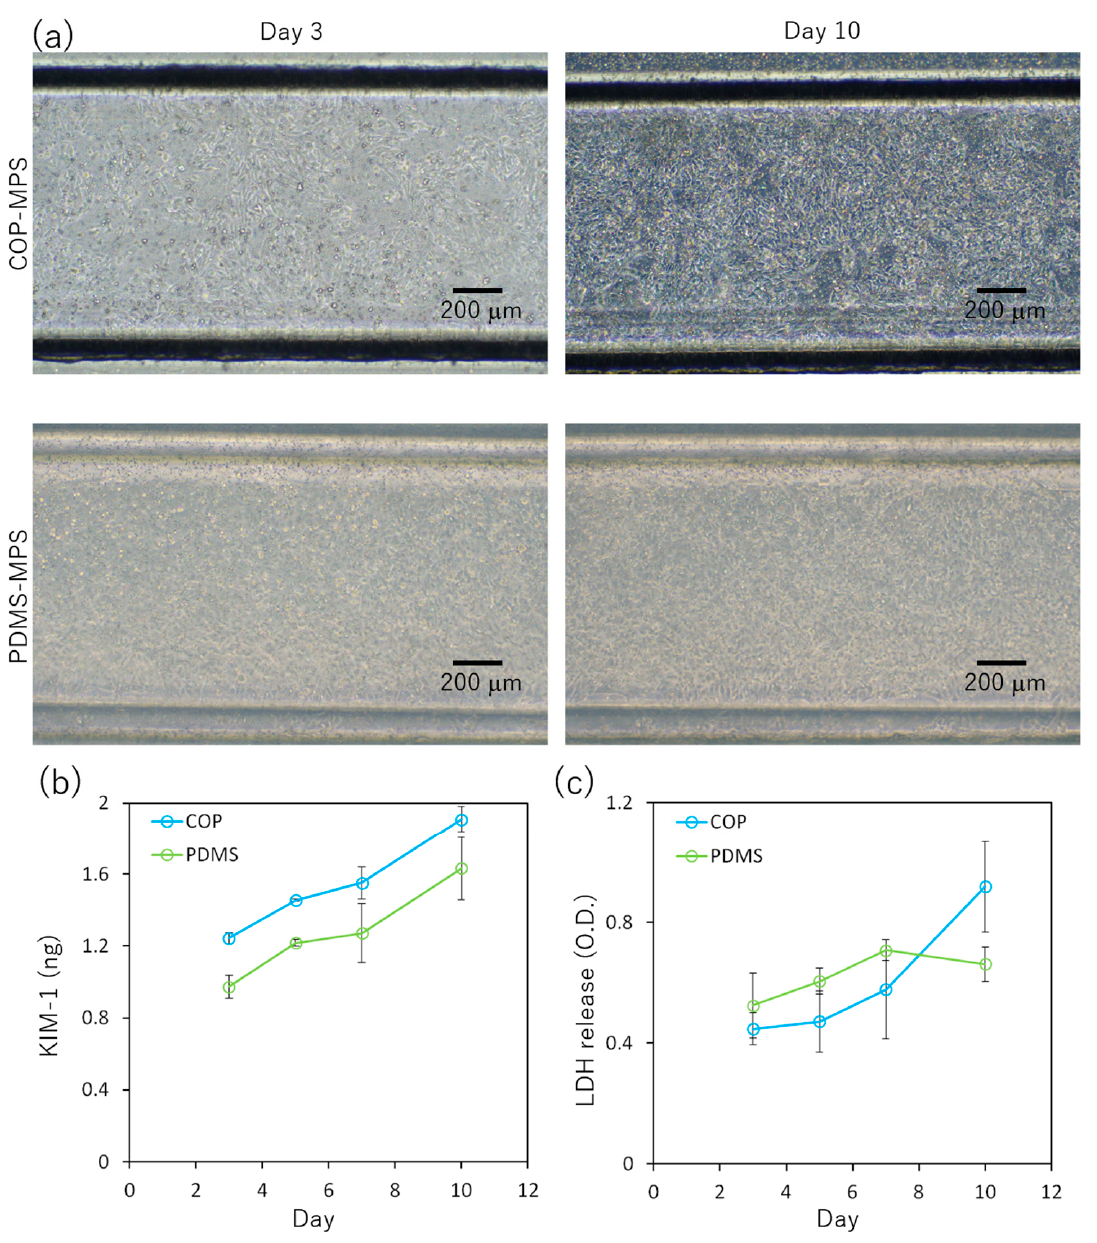
Figure 5. Comparison of cytotoxicity between COP-MPS and PDMS-MPS. ( a ) Phase-contrast images of RPTEC layers; ( b ) Time course of KIM-1 secretion; ( c ) Time course of LDH release. Data are presented as mean ± SD (technical replicates, n = 3). * p < 0.05.